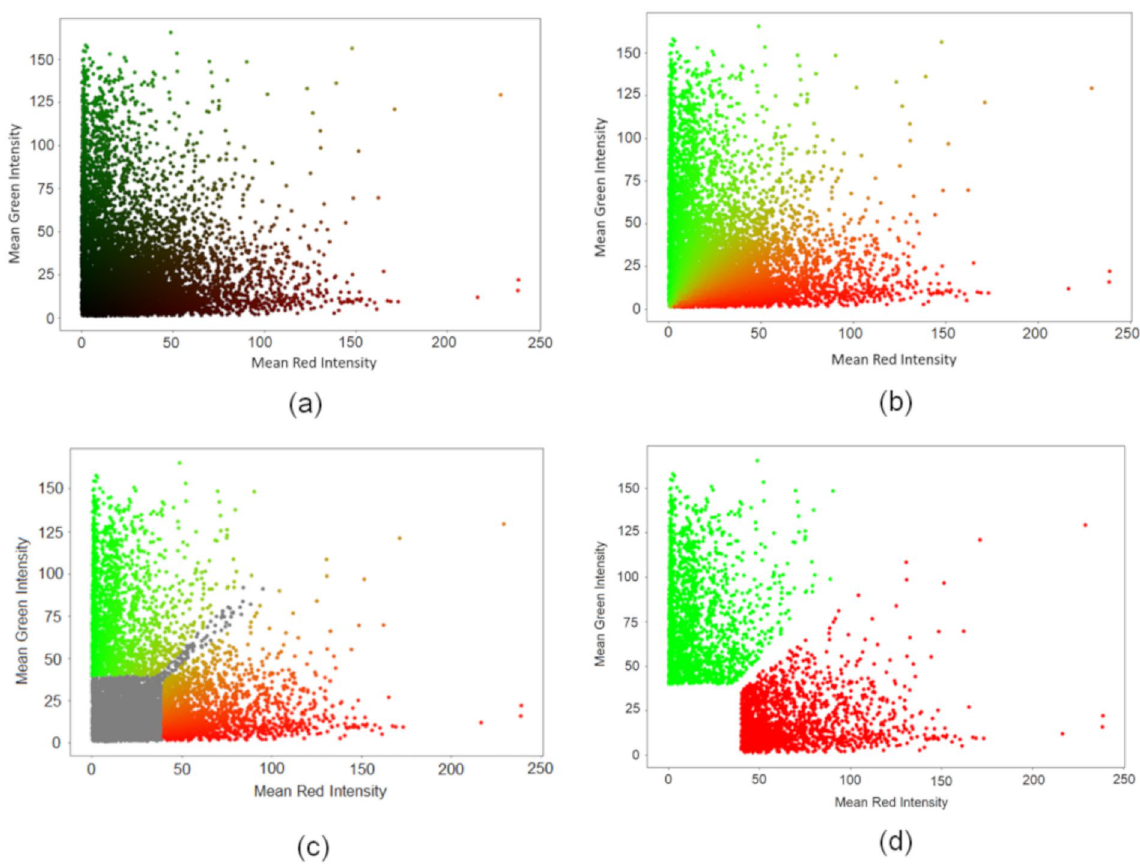
Figure 2. Nuclei distribution in the 2D space [ µ k r ,µ k g ] and strategy to automatically estimate the labels from the Fucci2 data to train the supervised classifier. (a) Each point is colored with the intensities (R,G,B) = [ µ k r , µ k g , 0]. (b) Each point is colored with the intensities (R, G, B) = are colored in grey. All the other nuclei are colored with the following intensities (R, G, B) = Representation of each nucleus in the 2D space [ µ k r ,µ k g ] after removing the colorless nuclei, outliers, and some nuclei in the transition between red and green. Each nucleus is represented by a single colored dot in the 2D space. Each point is colored with its label, i.e., nuclei labeled as S/G 2 are green, whereas nuclei labeled as G 1 are